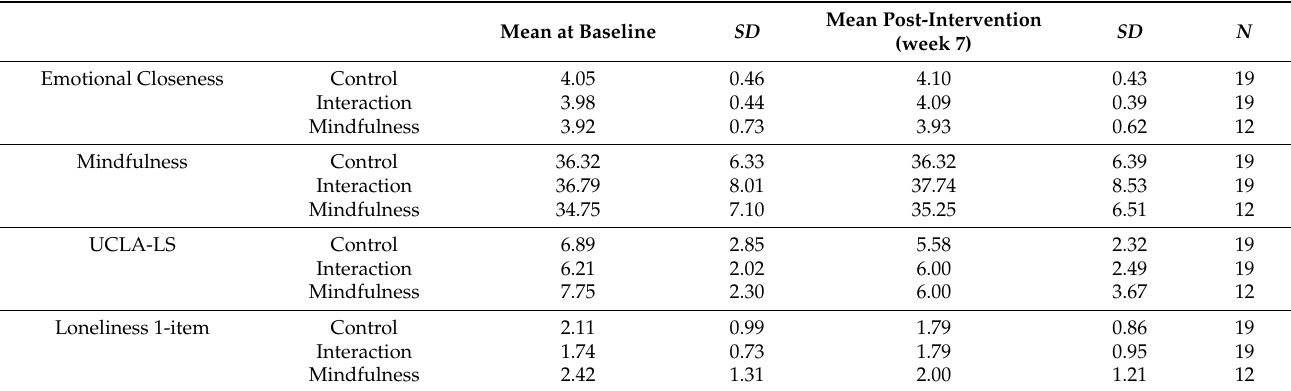
Table 5. Descriptive statistics for participants with complete data.